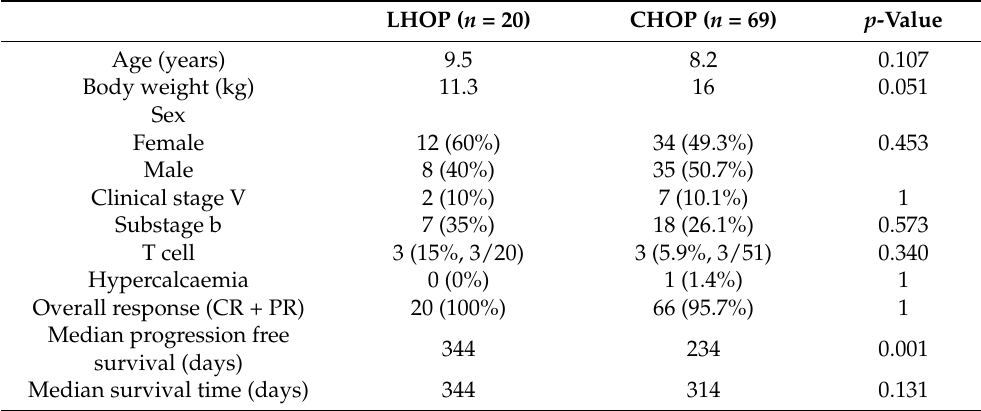
Table 3. Comparisons on signalment, negative prognostic factors, response, progression-free survival, and survival time between the LHOP and the CHOP treatment